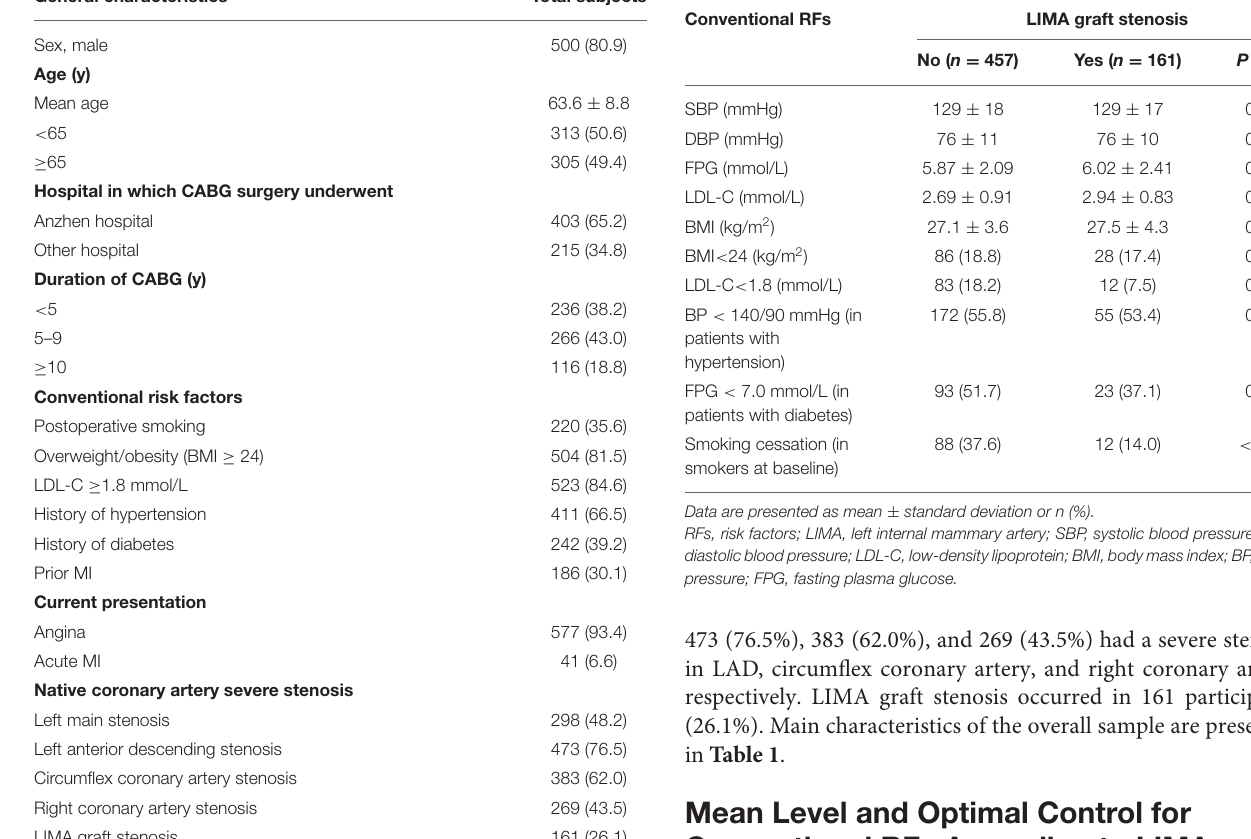
TABLE 2 | Mean level and the proportion of optimal control for conventional RFs according to LIMA graft stenosis. Conventional